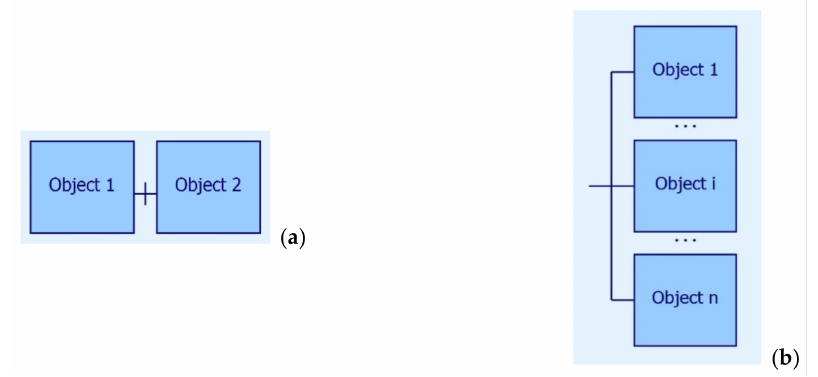
Figure 3. Adding objects: A + B ( a ), Σ A i ( b ).